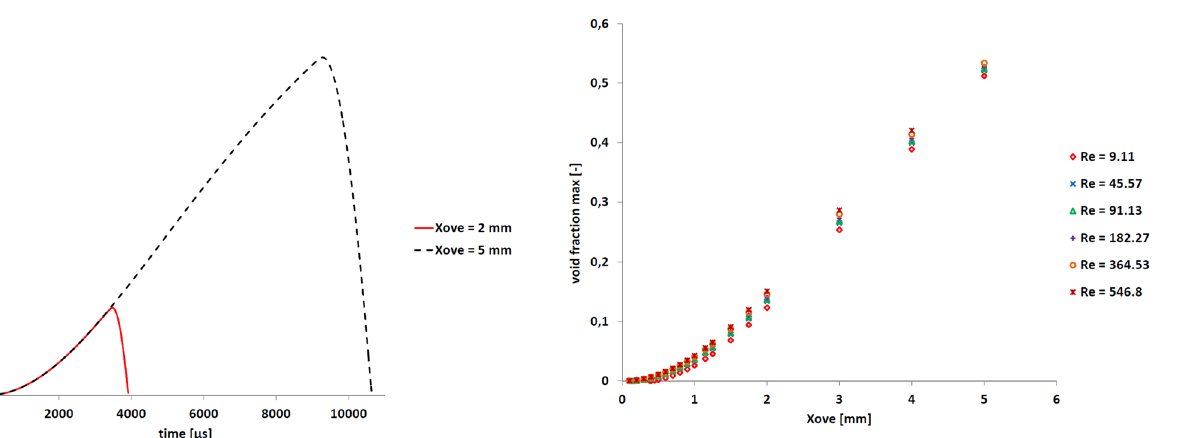
= 12 µm, p = 10 bar gap pump